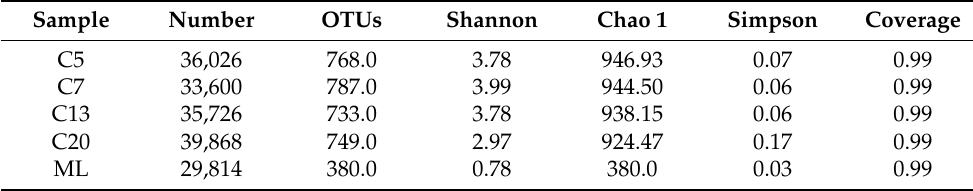
Table 2. The diversity estimators of microbes for different